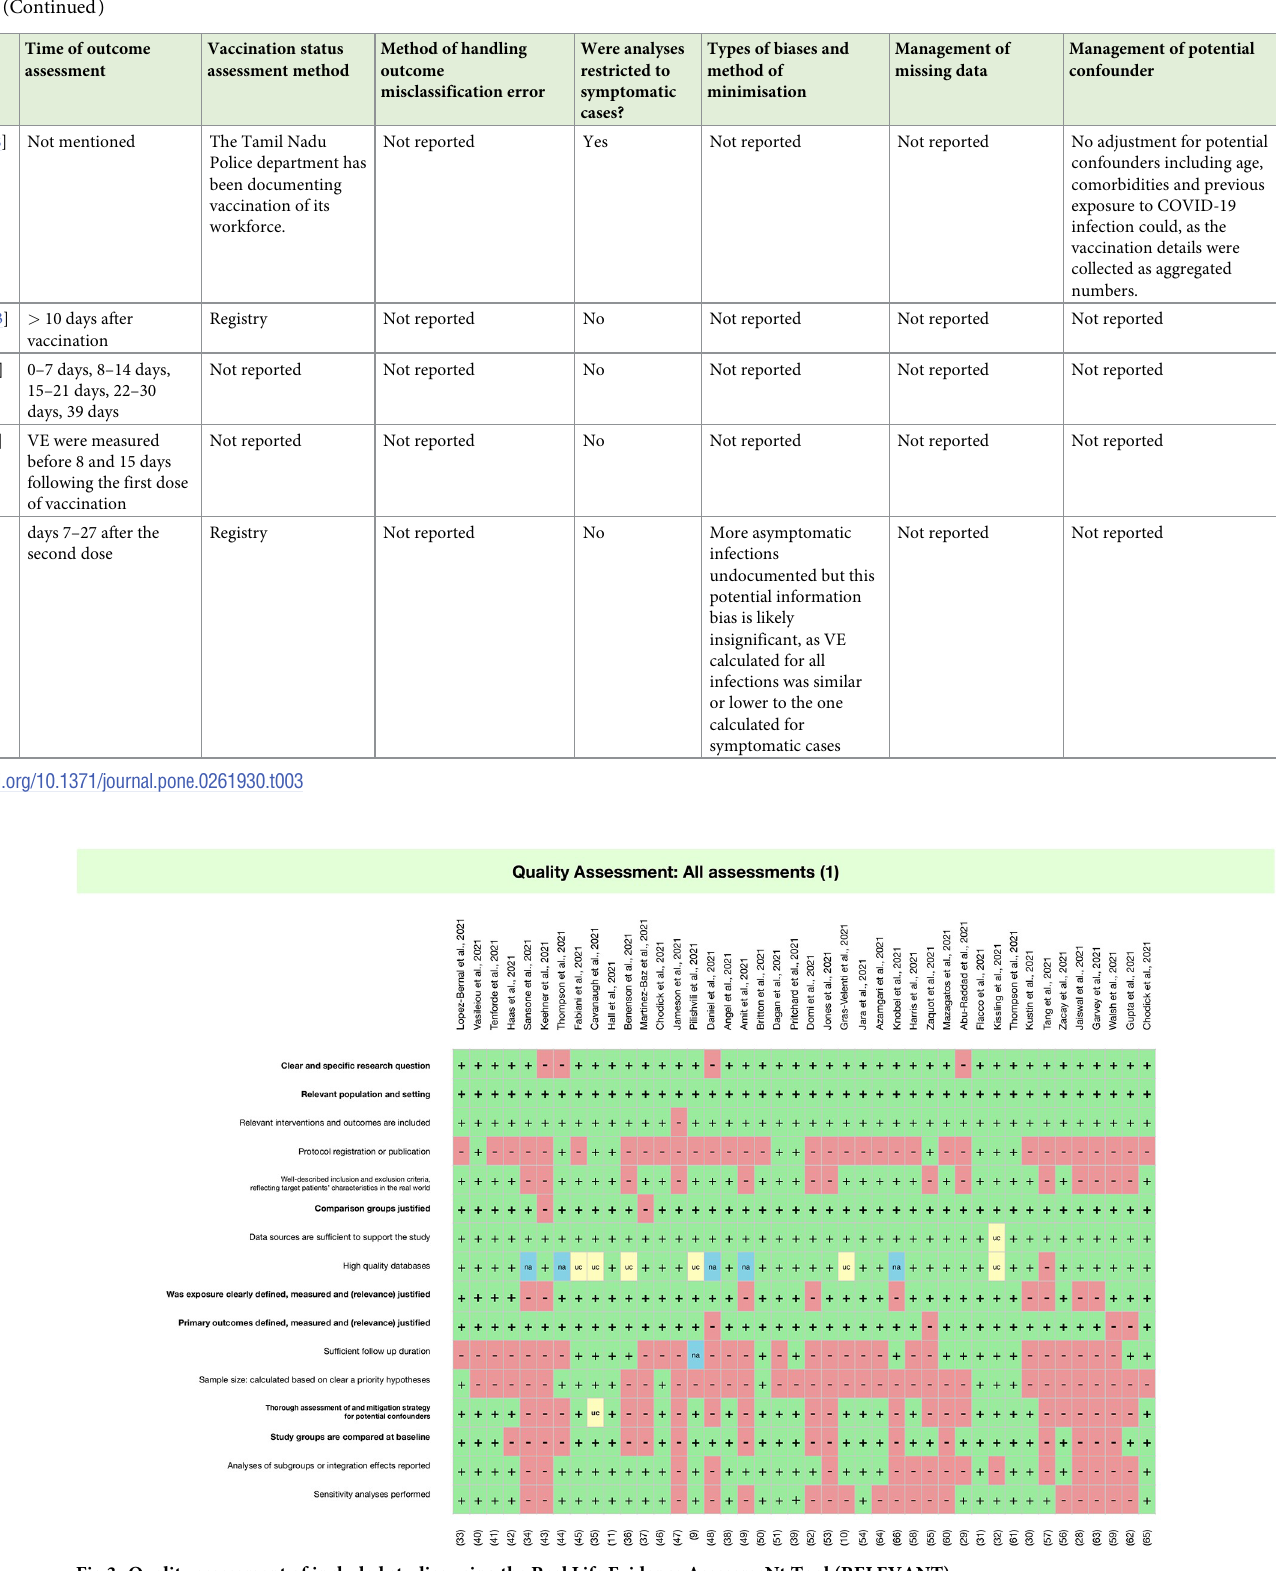
Fig 3. Quality assessment of included studies using the Real Life Evidence AssessmeNt Tool